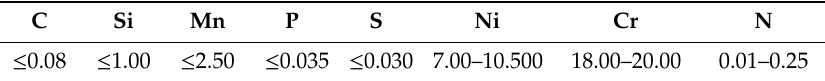
Table 1. Chemical compositions of SUS304 stainless steel plate (wt%).